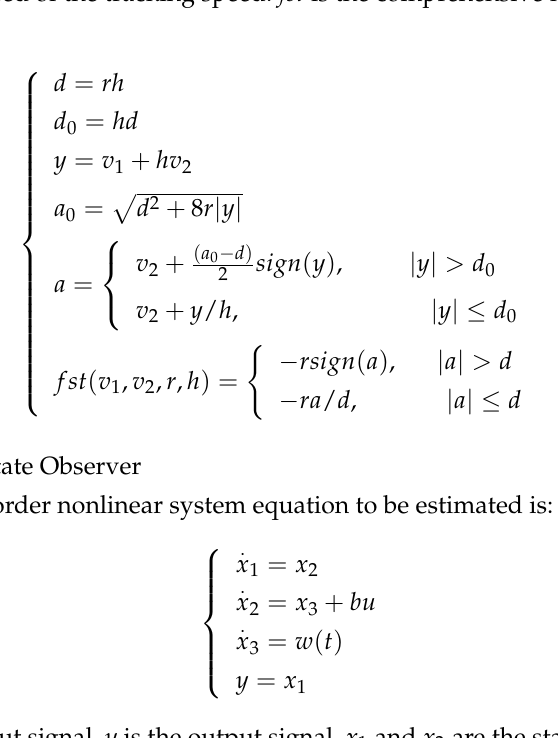
Figure 3. Structure of